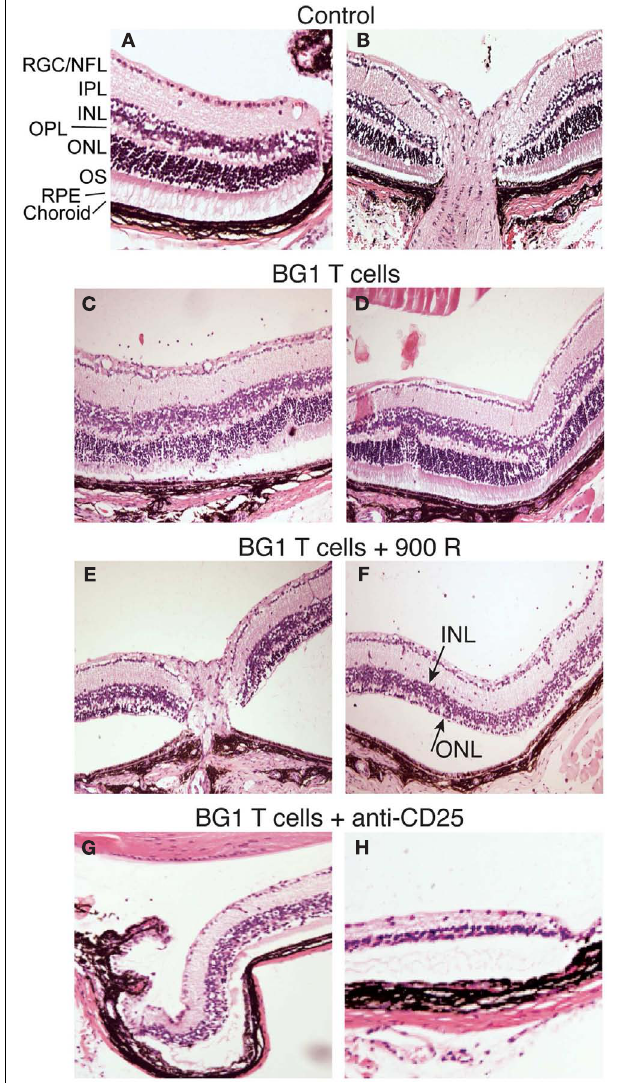
FIGURE 3 | Representative photomicrographs of autoimmune pathology in the eyes of arr β gal mice induced by transfer of activated BG1T cells. (A) Control retina, peripheral edge. (B) Control retina, optic nerve head. (C,D) . Pathology in arr β gal mice induced by peptide-activated BG1T cells. Eyes harvested 21days post-transfer. (E,F) Pathology induced in arr β gal mice by the transfer of activated BG1T cells after conditioning with 900RTBI. Eyes harvested 21days post-transfer. (G,H) . Pathology in the retinas of arr β gal mice that received anti-CD25 antibody prior to the transfer of activated BG1T cells. Eyes harvested 25days post-transfer. Abbreviations: RGC/NFL, retinal ganglion cell/nerve fiber layer; IPL, inner plexiform layer; INL, inner nuclear layer; OPL, outer plexiform layer; ONL, outer nuclear layer; OS, outer segments; RPE, retinal pigment epithelium.